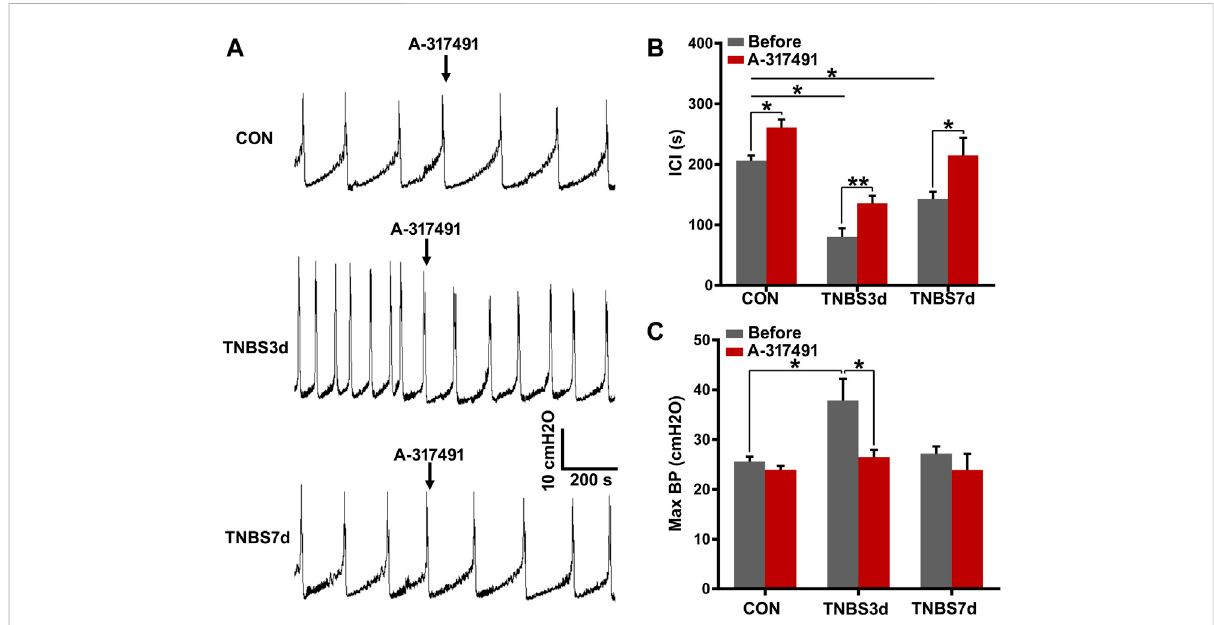
FIGURE 6 Inhibition of P2X3 alleviated bladder overactivity evoked by TNBS-induced colitis. (A) Representative tracers of cystometry patterns from three groups responded to A-317491 by intrathecal injection. The rats with colitis exhibited bladder overactivity, manifested by increased micturition frequency and bladder pressure. n =4 for eachgroup. (B) Histogram showed that theICI ofrats treated with TNBS wassigni fi cantly shorterthan that of the control group, and intrathecal injection with A-317491 signi fi cantly prolonged the ICI of both control and colitis groups. (C) Histogram showed that colitis signi fi cantly increased the maximum BP of rats at day 3 post-TNBS but not at day 7 post-TNBS. Intrathecal injection with A- 317491 signi fi cantly inhibited the increased maximum BP at day 3 post-TNBS. * p < 0.05, ** p < 0.01 by Student ’ s t-test or one-way ANOVA followed by Newman – Keuls post hoc